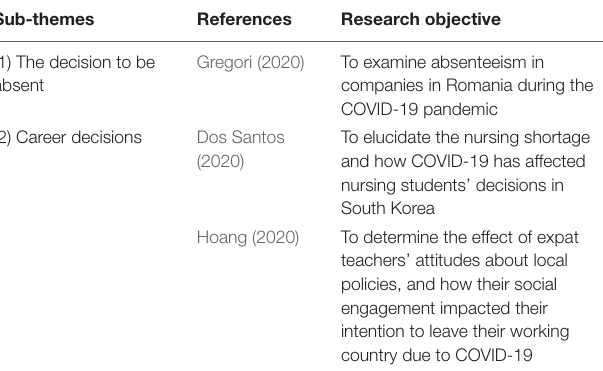
TABLE 6 | Articles on influences on career